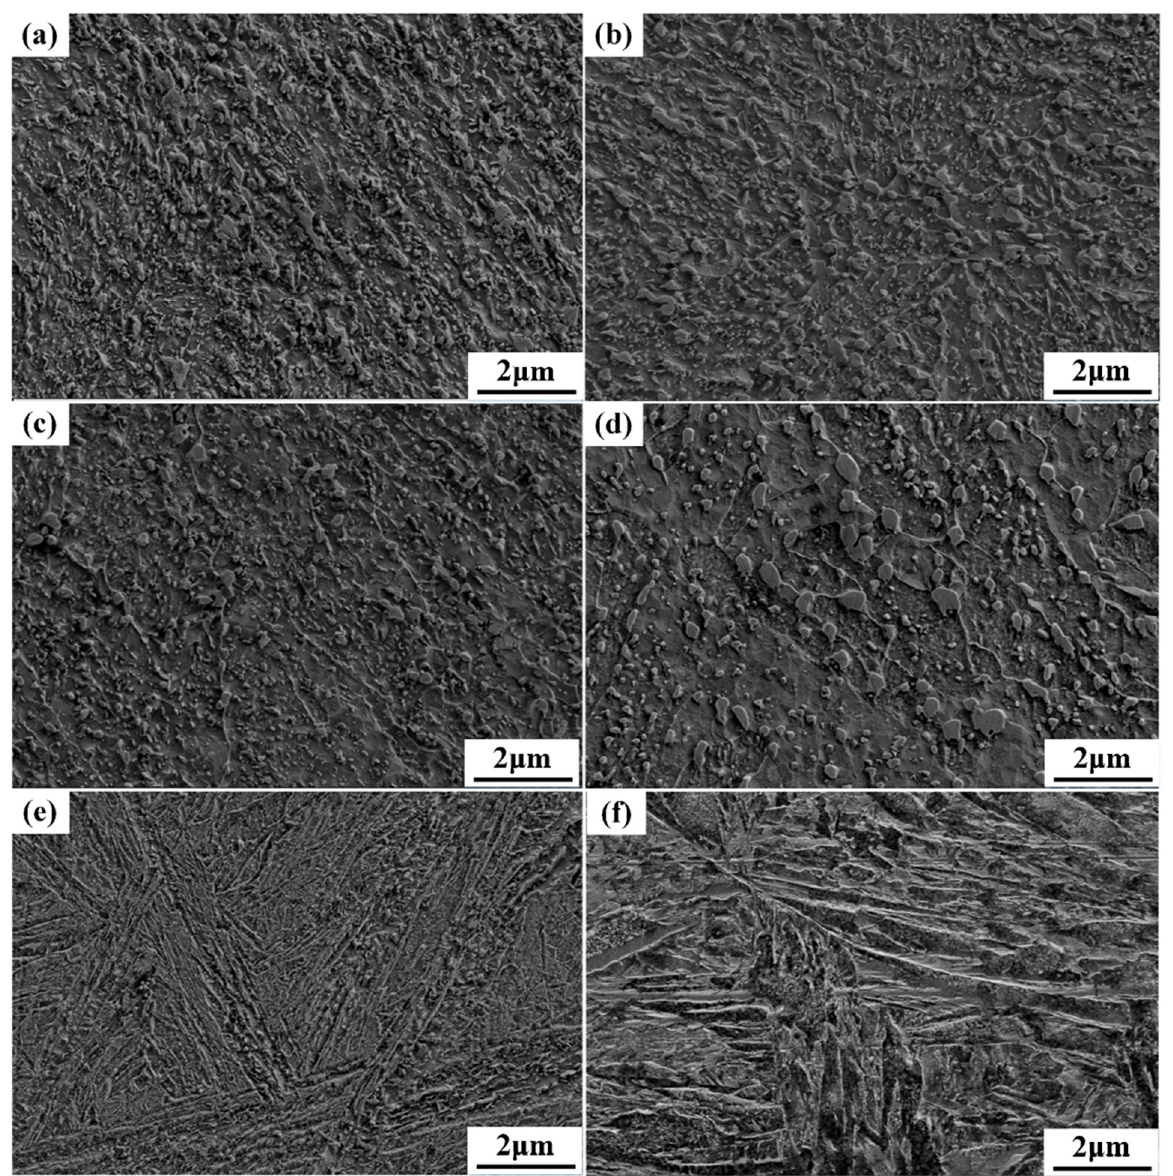
Figure 3. SEM images of the microstructure of 35CrMo steel after tempering at different temperatures: ( a ) 580 °C, ( b ) 610 °C, ( c ) 640 °C, ( d ) 680 °C, 710 °C, and ( f ) 740 °C.